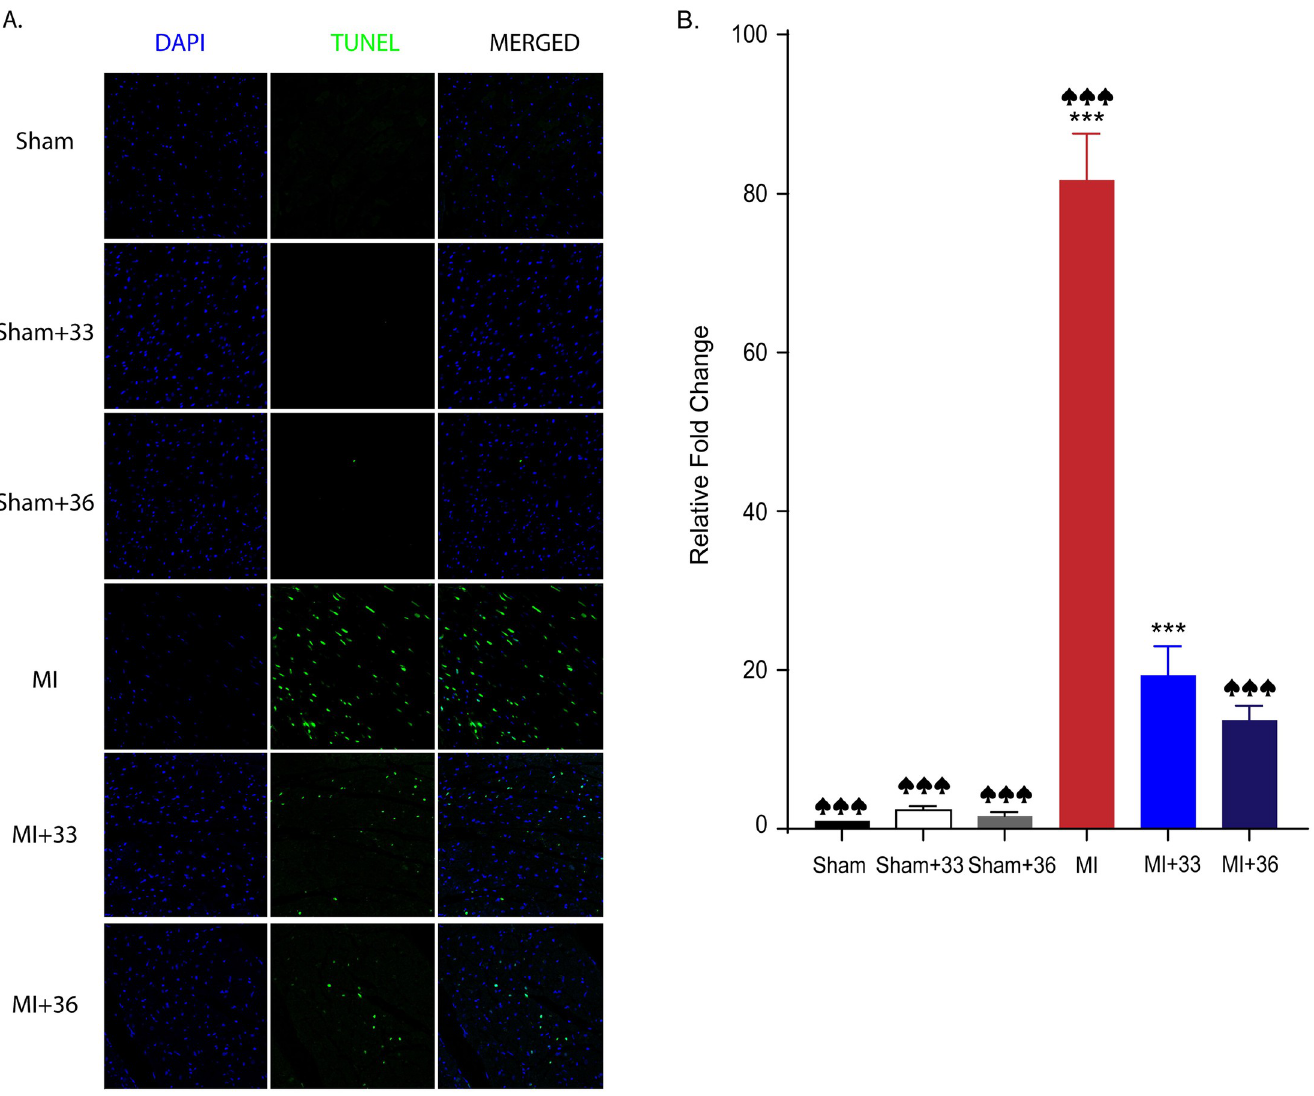
Fig 3. Quantitative analysis of apoptotic cell death by TUNEL assay. A. Representative TUNEL assay results for 33˚C and 36˚C targeted temperature management after myocardial I/R injury. B. TUNEL assay results (the number of animals: n = 5, respectively), ♠♠♠ P < 0.001, comparing sham with normothermia and hypothermia (33˚C and 36˚C), ��� P < 0.001, comparing myocardial I/R with normothermia and hypothermia (33˚C and 36˚C); Statistical analyses were performed by one-way analysis of variance (ANOVA) followed by Bonferroni post hoc tests for multiple comparisons between groups.